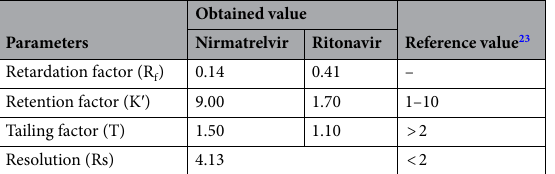
Table 2. TLC system suitability testing parameters for the determination of nirmatrelvir and ritonavir.